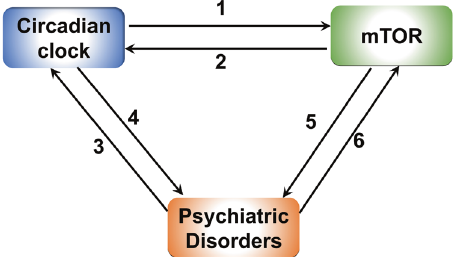
Fig. 1 A proposed “ interaction triangle ” model between the circadian clock, mTOR signaling, and psychiatric diseases. 1. The circadian clock temporally regulates mTOR activities in different tissues. 2. mTOR signaling regulates the central and peripheral circadian clock functions. 3. Psychiatric disorders can cause disruption of circadian rhythms. 4. Circadian dysfunction can contribute to the pathogenesis of psychiatric disorders. 5. Aberrant brain mTOR activities lead to psychiatric diseases. 6. Psychiatric disorders can lead to dysregulation of mTOR activities in the